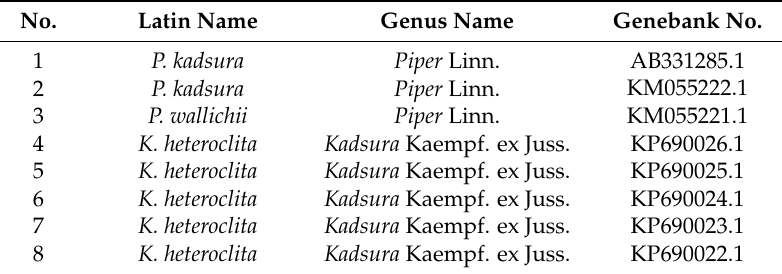
Table 3. The list of accessions downloaded from